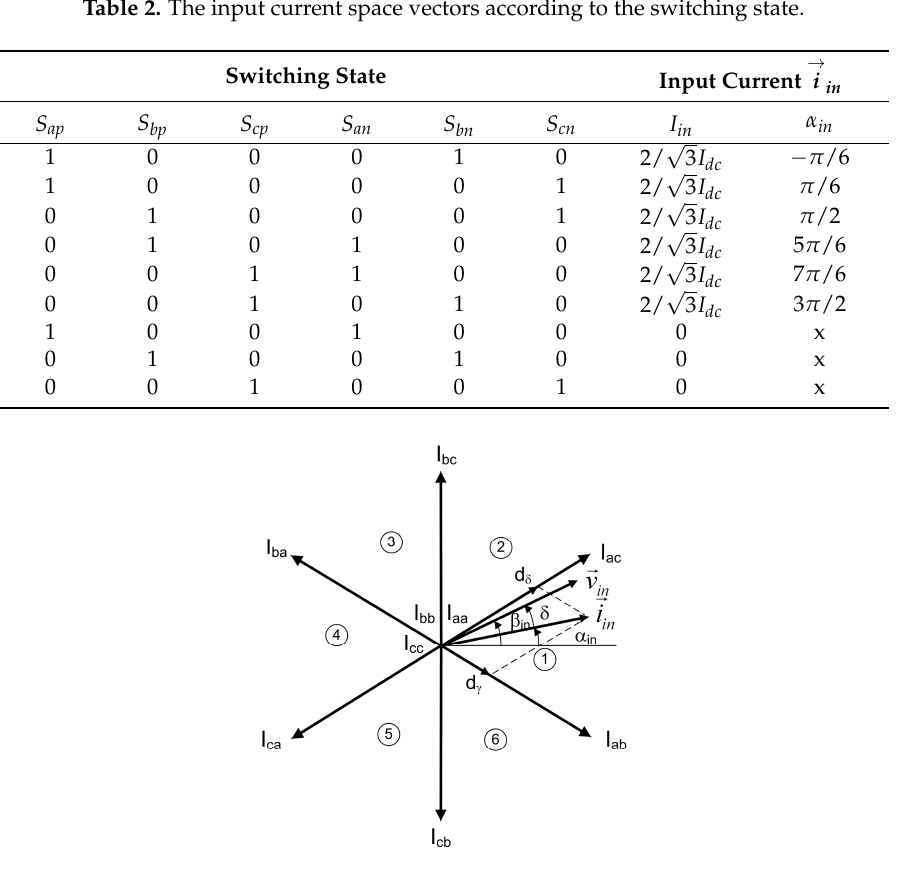
Table 2. The Input Current Space Vectors According to the Switching State. Table 2. The input current space vectors according to the switching state.